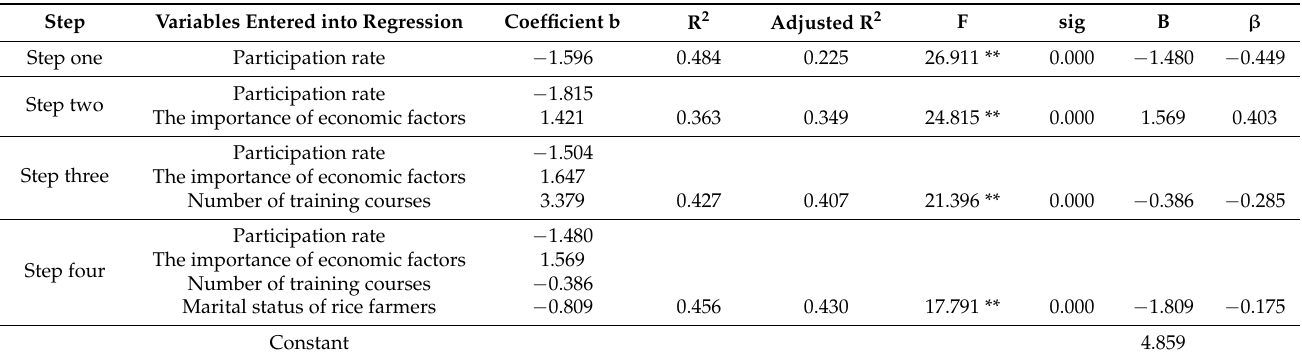
Table 5. Multivariate stepwise regression in relation to the effect of independent variables on the amount of training needs assessment of female rice farmers.